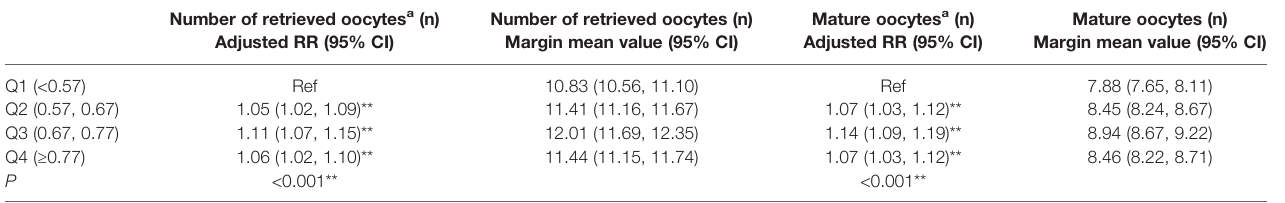
Number of retrieved oocytes (n) Margin mean value (95% CI)